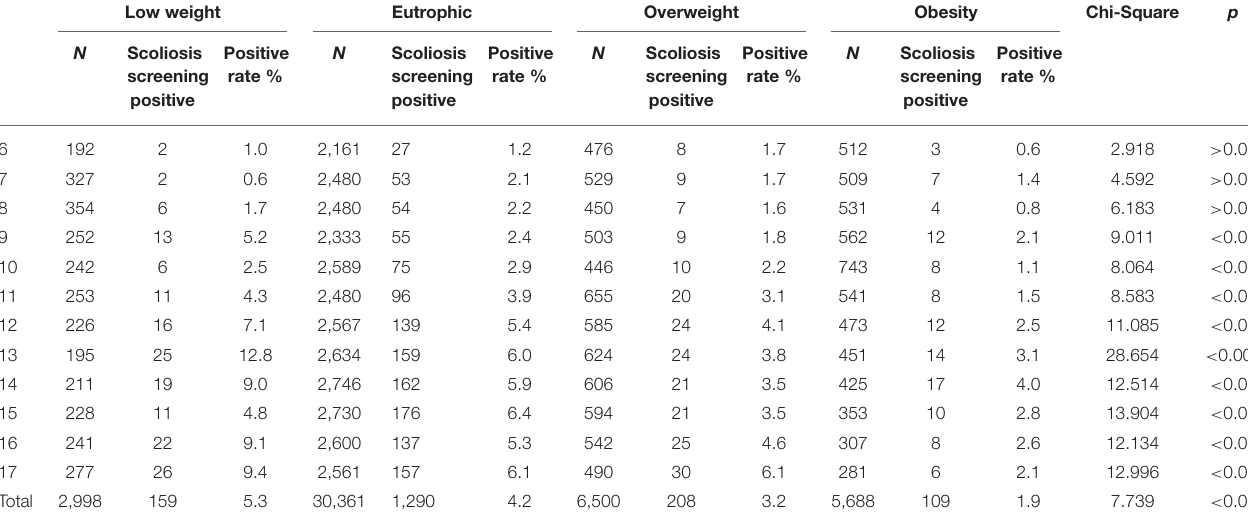
TABLE 3 | The prevalence of scoliosis screening is positive among students stratified by nutritional status. Low weight Eutrophic Overweight Obesity Chi-Square